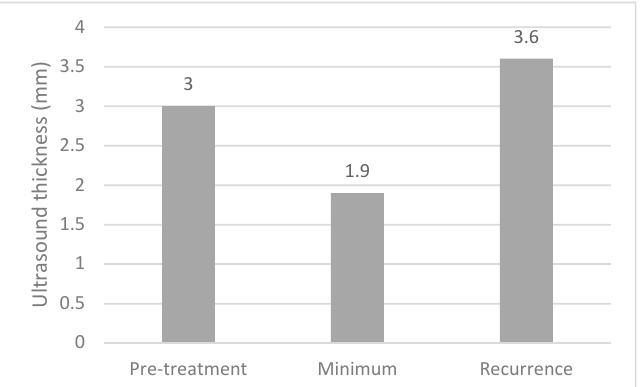
Figure 3. Bar chart demonstrating the median thickness of choroidal melanomas at diagnosis, at their minimum post-treatment and at recurrence (all measurements in mm). Paired t -tests demonstrated a significant difference between pre-treatment and minimum measurements and between minimum measurements and recurrence ( p < 0.001).